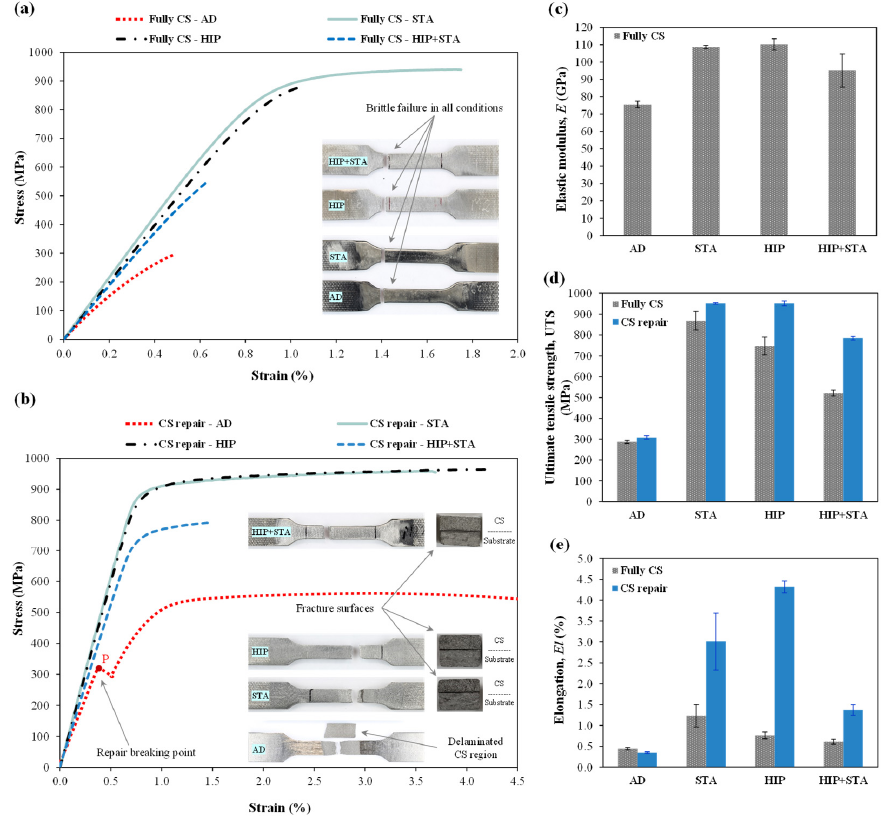
Figure 4. Tensile properties in four different conditions, i.e., AD, STA, HIP, and HIP + STA: ( a ) fully CS specimen: stress–strain curves, ( b ) CS repair specimen with 2:5 repair ratio: stress–strain curves, comparison among ( c ) elastic moduli of fully CS material calculated from the stress–strain curve, ( d ) ultimate tensile strength, and ( e ) elongation.